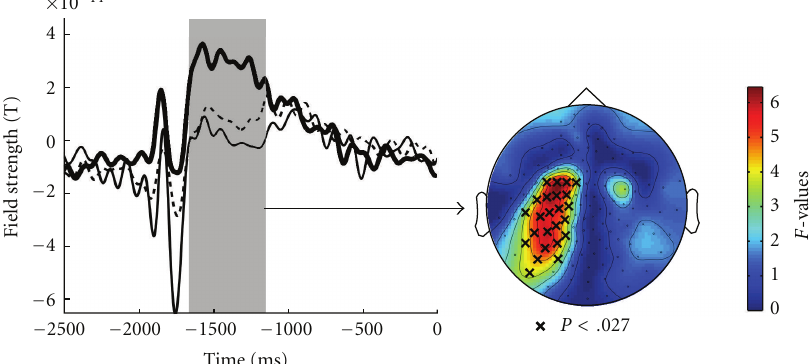
Figure 3: Time course of field strength as in Figure 2(b) for the down regulate condition (blue cross cue) averaged separately for HC (solid thick line), MDD patients (dashed line), and BPD patients (solid thin line). The gray bar marks the epoch of significant group di ff erences. The right panel illustrates sensors defining the significant cluster marked by “x” (referring to the group di ff erences).